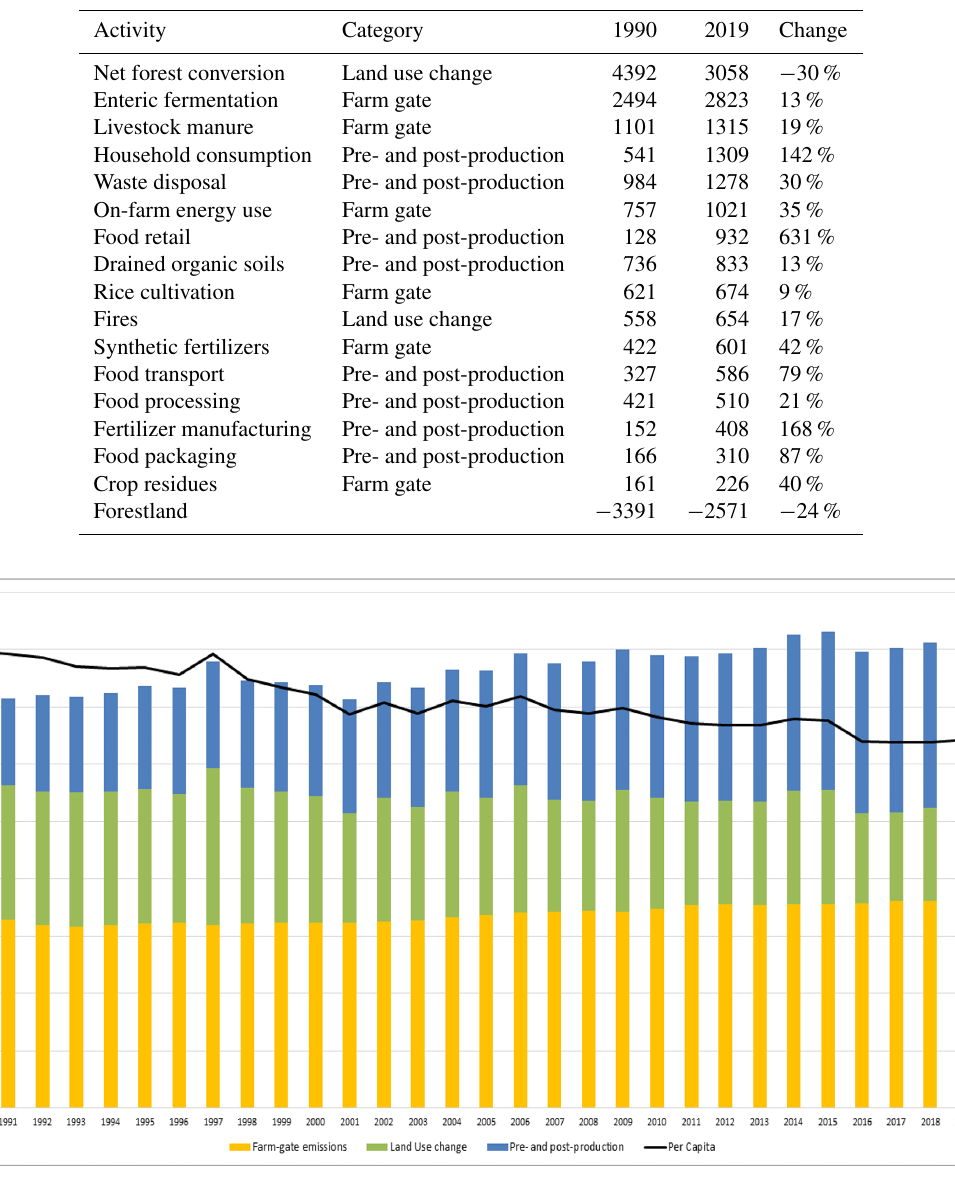
Table 1. GHG emissions (MtCO 2 eq.) by agri-food system component for all processes considered in this work. Data on forestland removals are provided for completeness of land-based emissions available in FAOSTAT. Uncertainties (not shown) are estimated at 30% for farm gate and pre- and post-production components and at 50% for land use change processes.